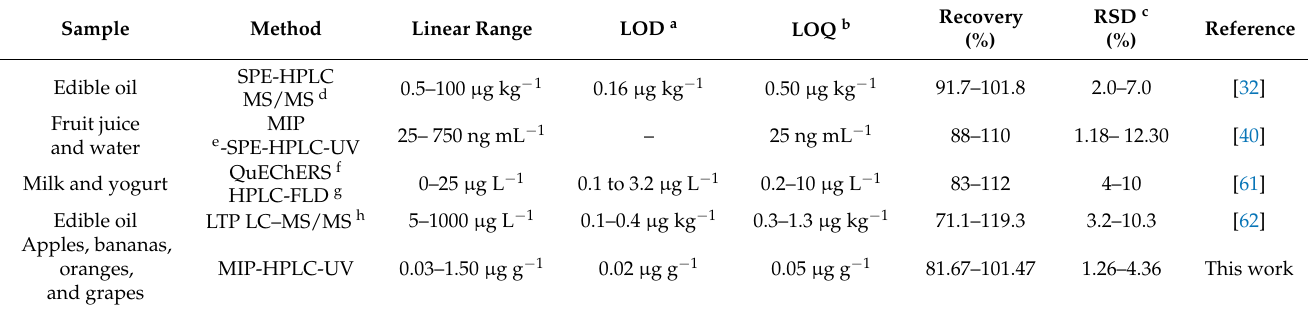
Table 6. Comparison of the present work with previously reported methods for ABM